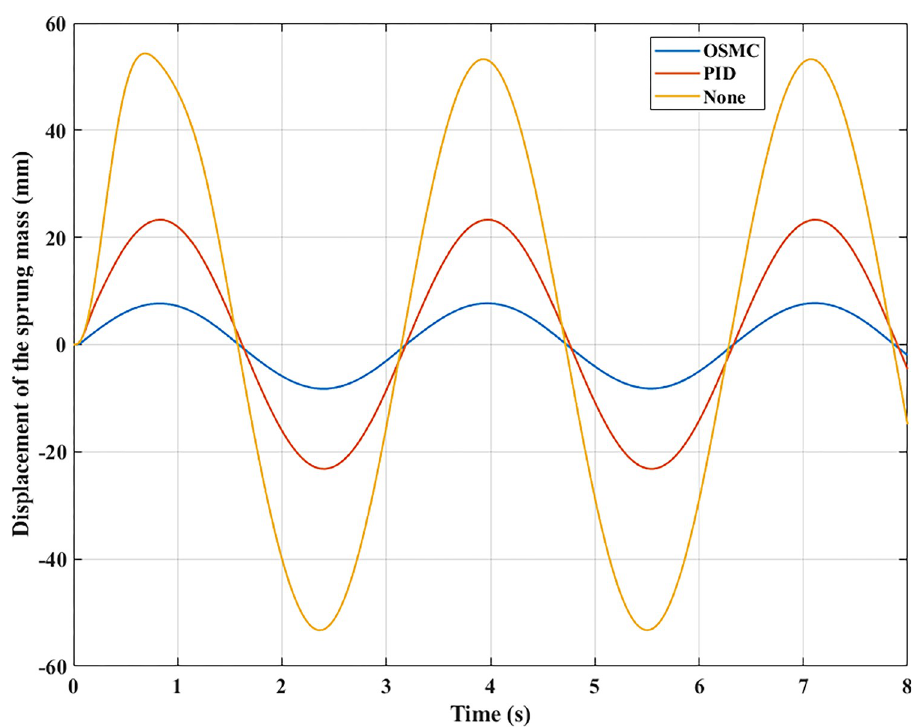
Fig 5. Displacement of the sprung mass (case 1).